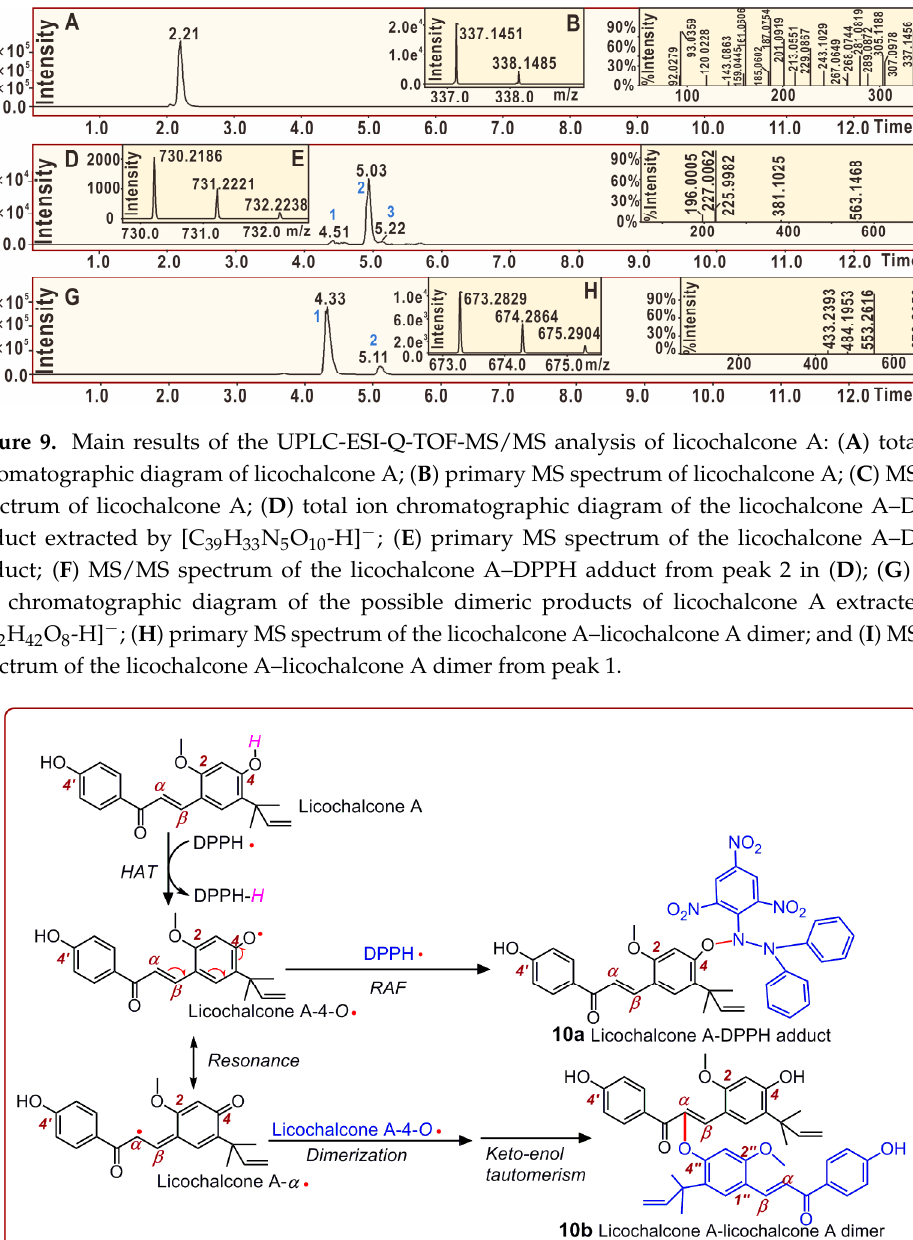
Molecules 2019 , 24 , x